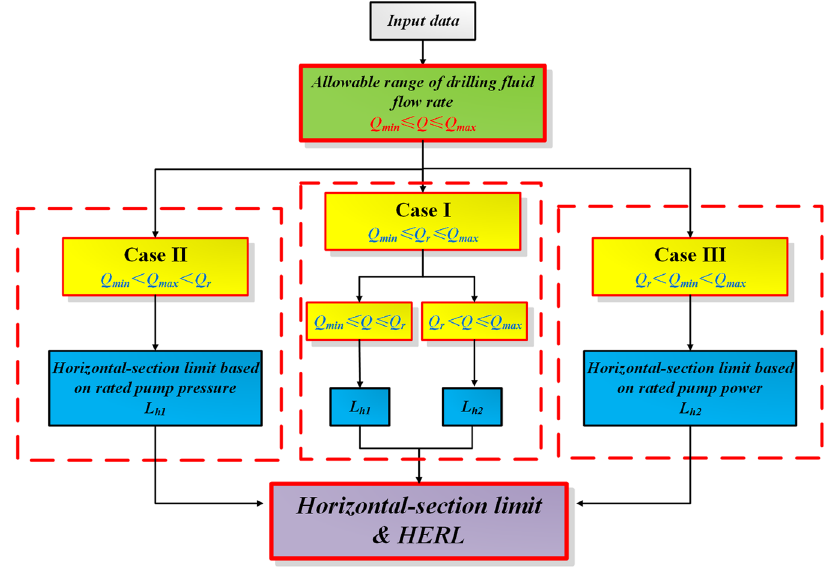
Figure 5. Flow chart of the calculation